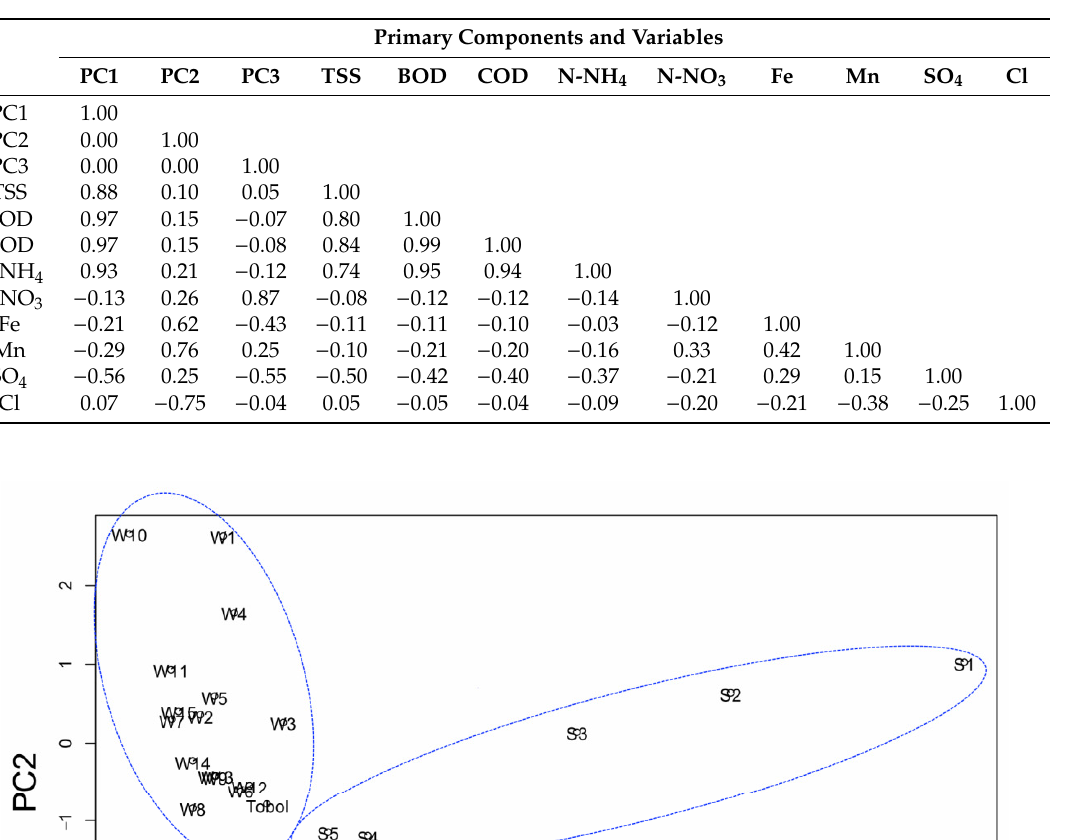
Table 6. Correlation matrix for analyzed variables.